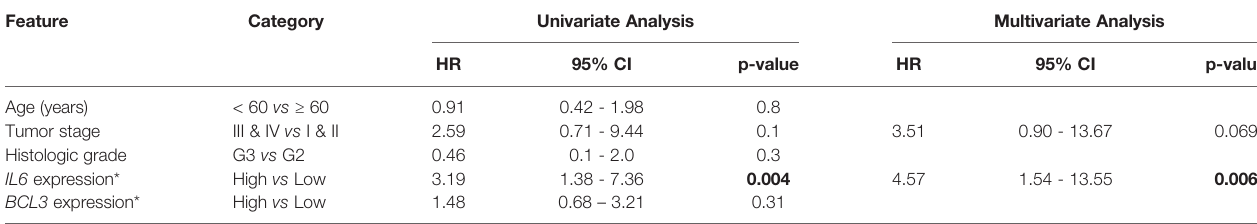
TABLE 2 | Overall survival